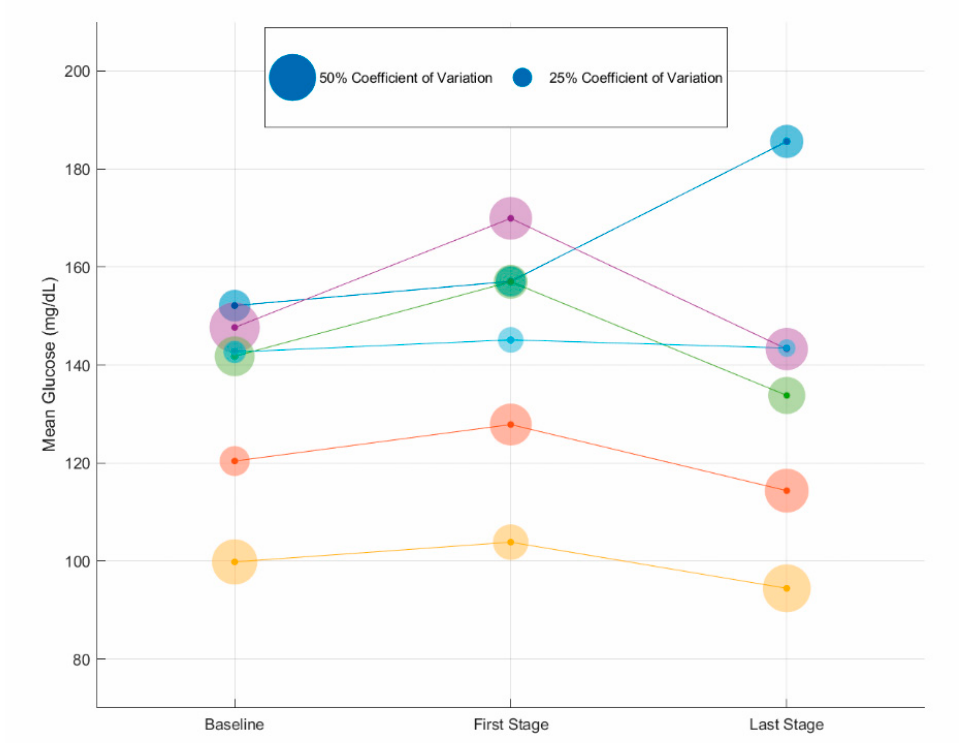
Figure 3. Evolution of the mean glucose values and coe ffi cient of variation (CV) evaluated with isCGM for every patient of the 24-h observation window. Each bubble is centered in the mean glucose value for each patient and stage of the study, while the area of each circle is proportional to the CV.